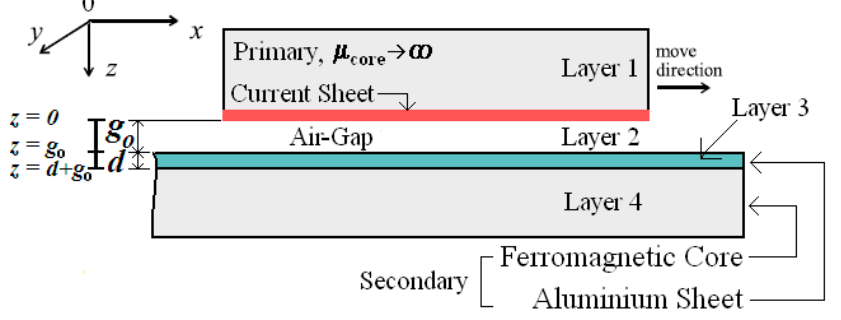
Figure 3. The layer model of the induction planar actuator.